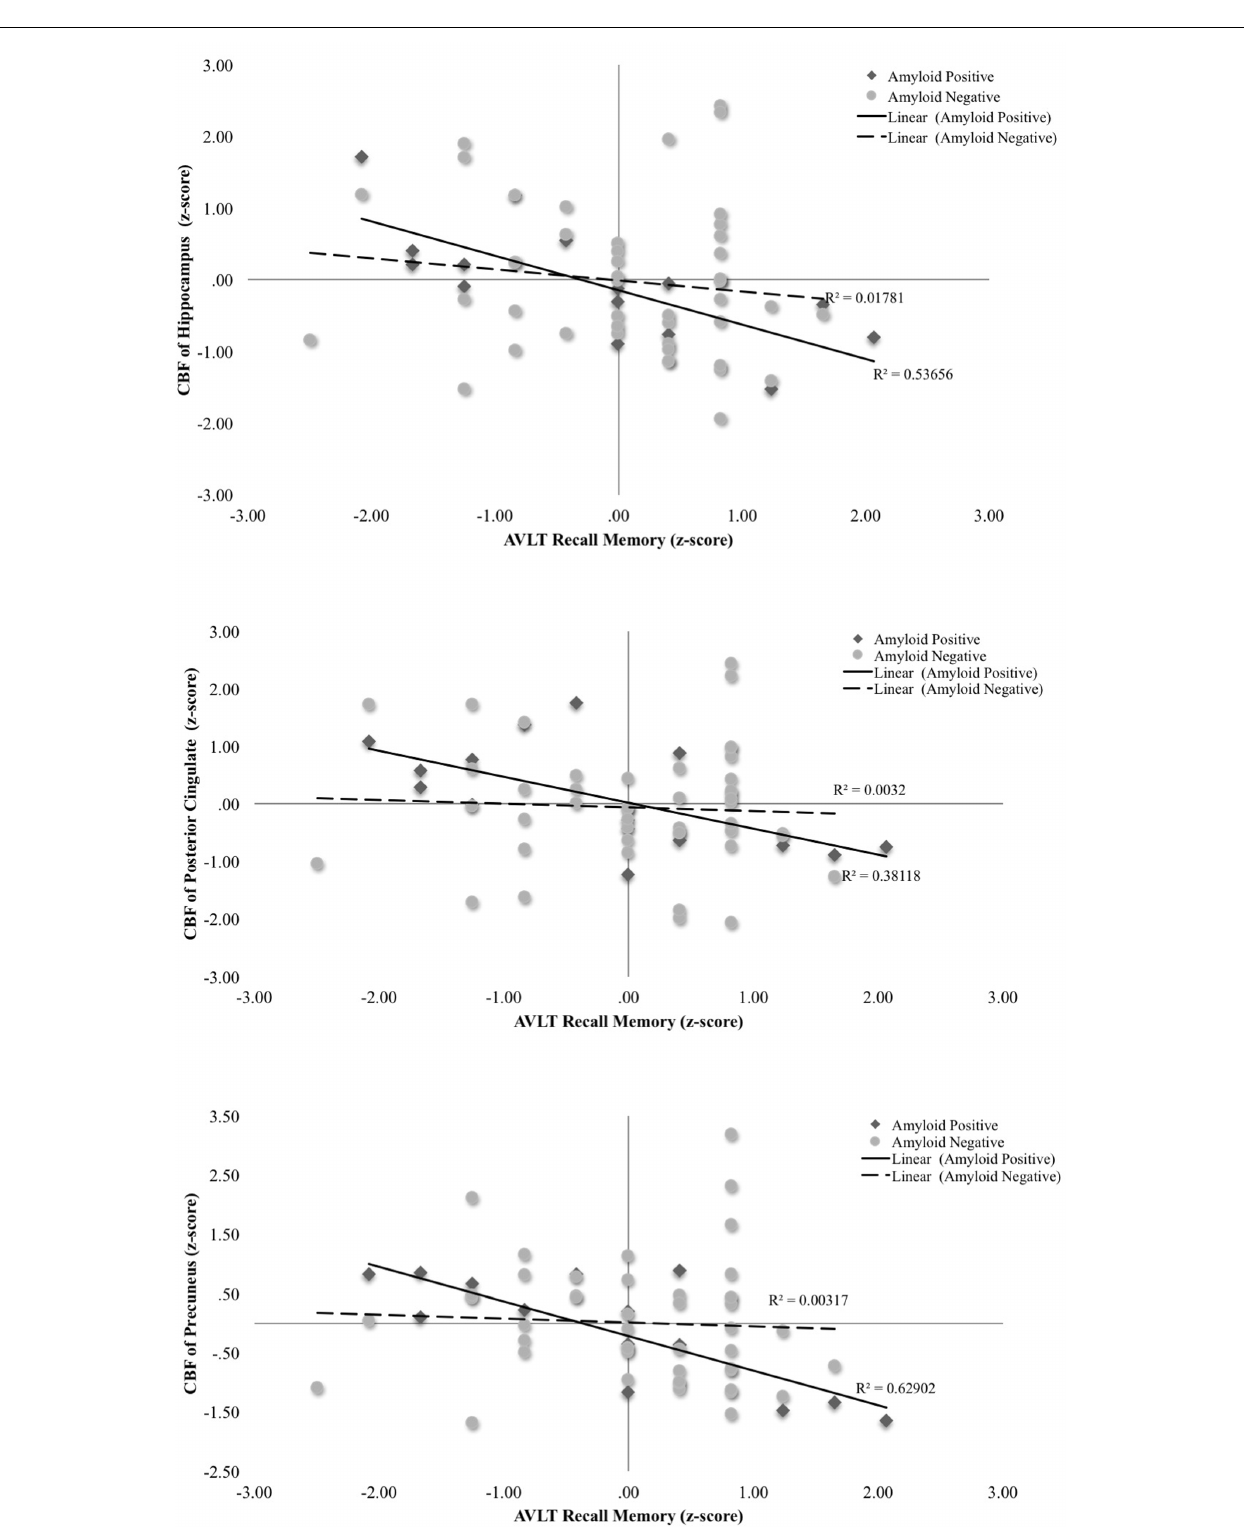
Frontiers in Aging Neuroscience |